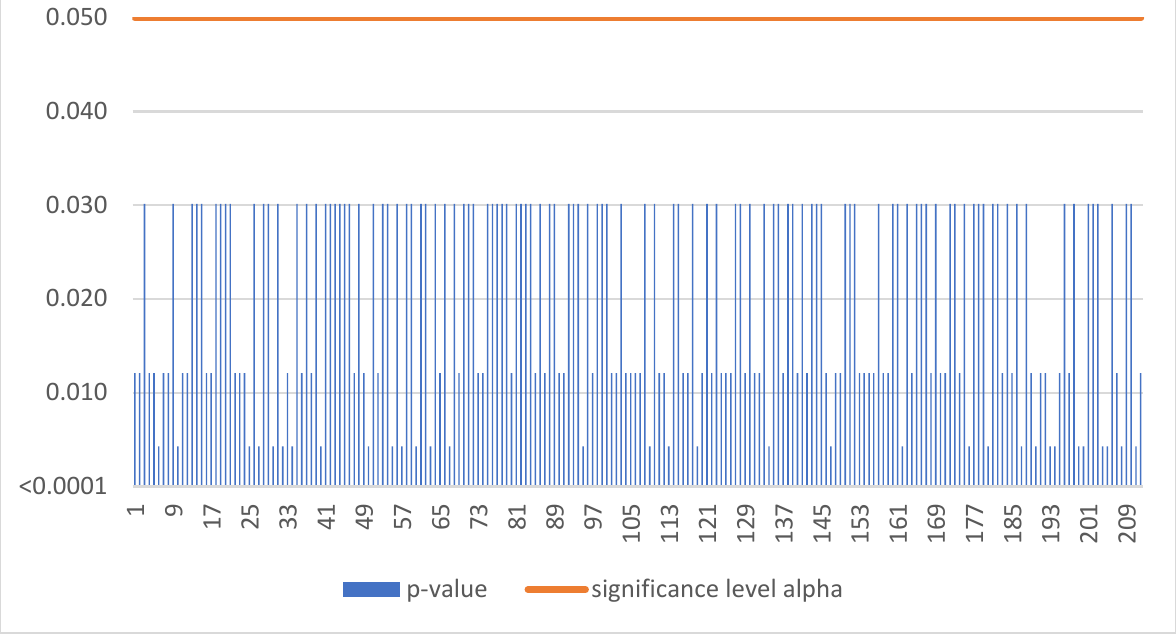
Figure 7. Negative trend in Hungary.